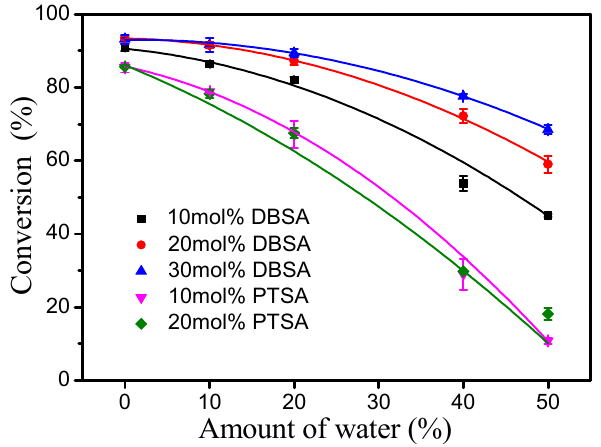
Figure 4. Effect of water content on the esterification of oleic acid using DBSA or PTSA. Reaction conditions: a reaction temperature of 40 °C, a molar ratio of 1.3:1 oleic acid to alcohol and a reaction time of 4 h.